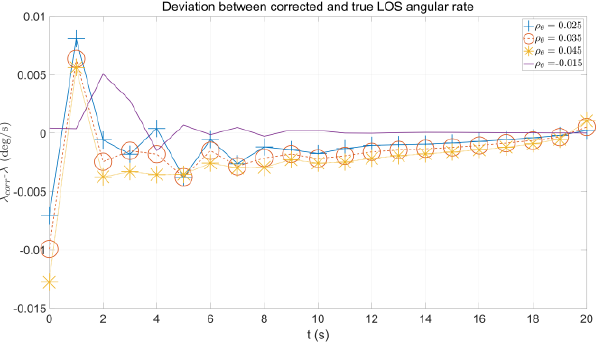
. λ corr and the true LOS angular rate  and the true LOS angular rate corr  . 